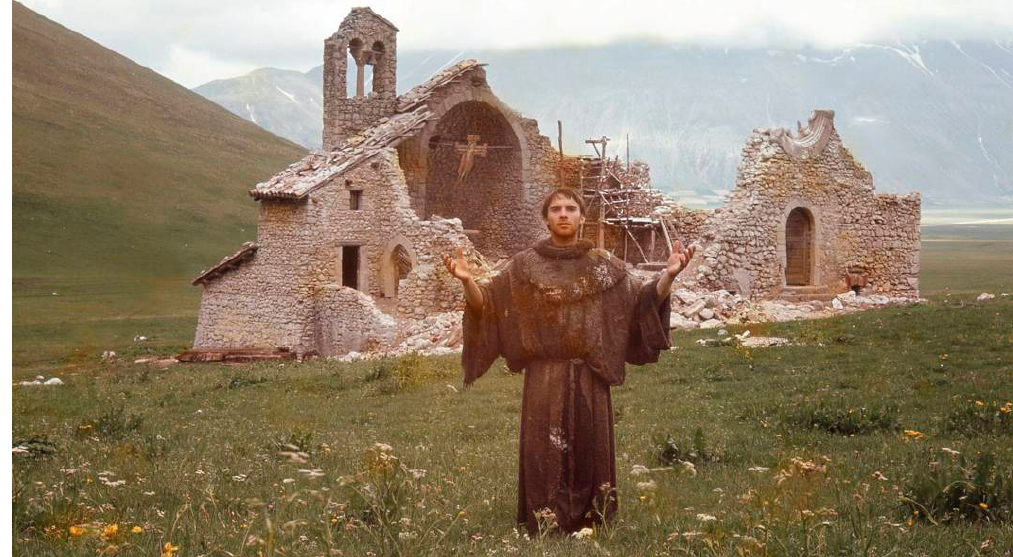
Figure 6. Fratello Sole , Sorella Luna (Franco Zeffirelli, 1972),